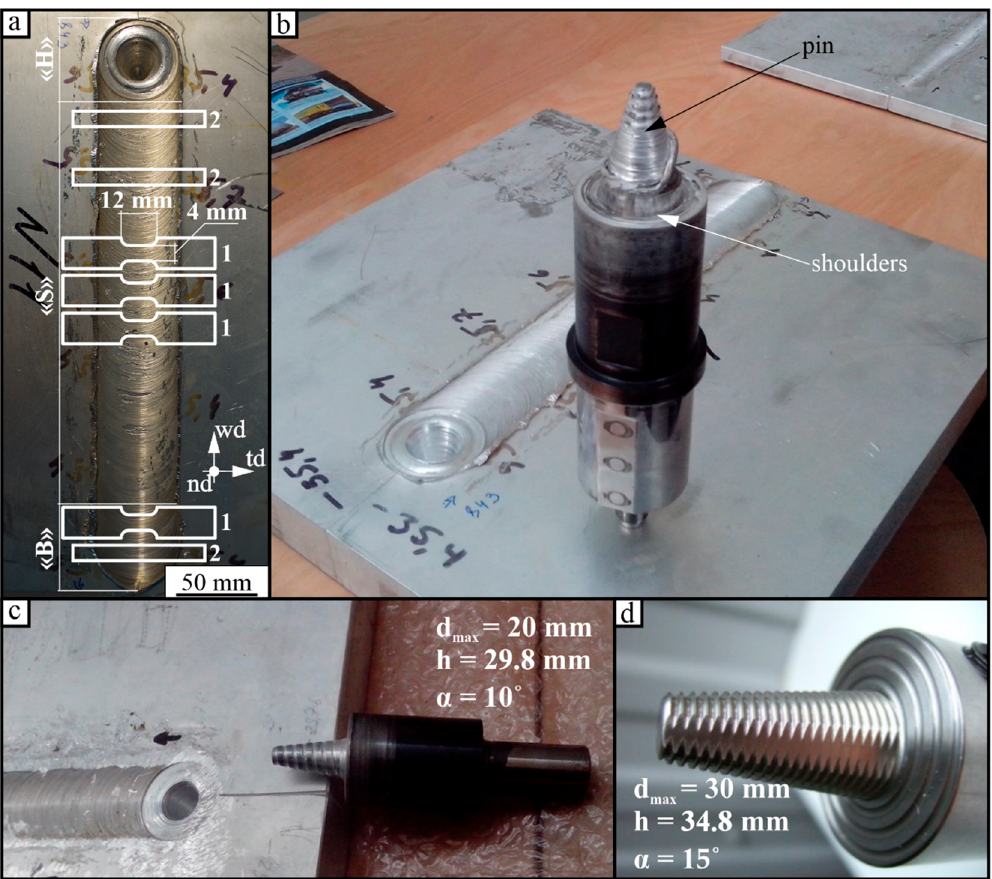
Figure 1. The friction stir welding (FSW) seam zones on a 35 mm thick AA1570 sheet ( a ), the FSW tool used for the 35 mm thick sheet after welding ( b ), the FSW tool used for the 30 mm thick sheet after welding ( c ), and the FSW tool used for the 35 mm thick sheet before welding ( d ). 1–tensile specimens;